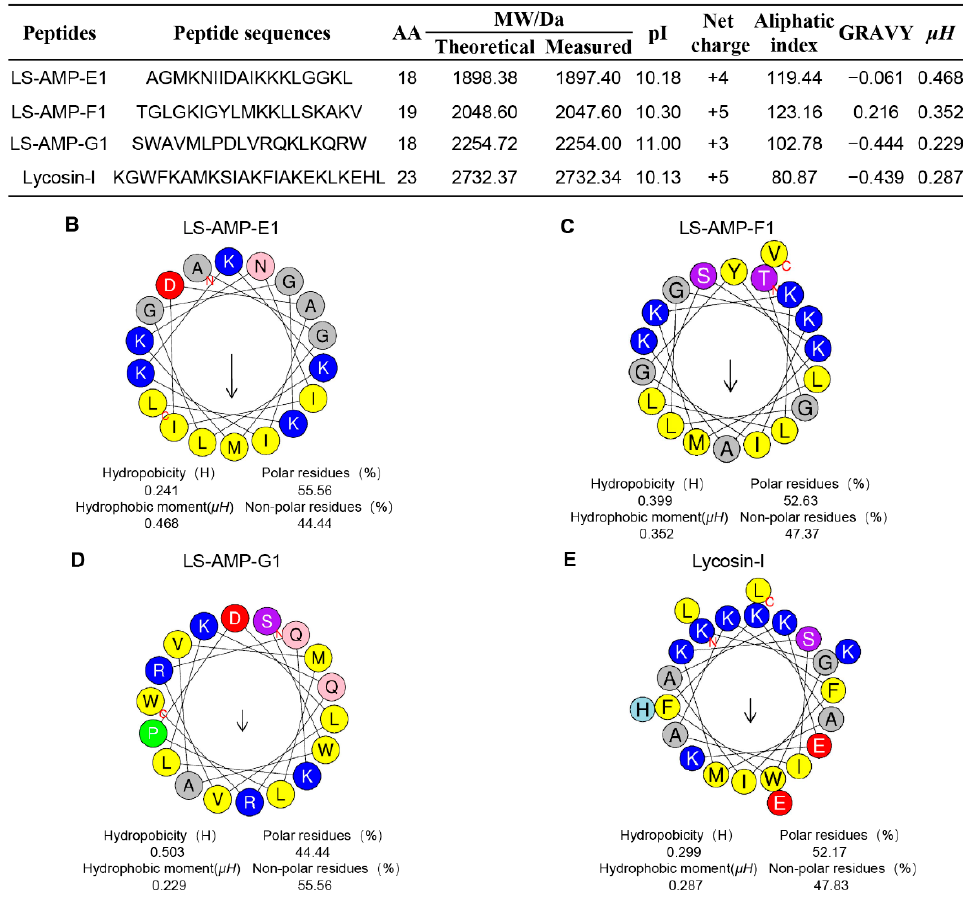
Figure 1. Physicochemical properties ( A ) and helical wheel projection of LS-AMPs ( B ), LS-AMP-E1; ( C ), LS-AMP-F1; ( D ), LS-AMP-G1; ( E ), Lycosin-I. The hydrophobic residues are yellow, positively charged hydrophilic residues are blue, and negatively changed hydrophilic residues are red. The noncharged polar residues are purple. Abbreviations, MW/Da: average molecular mass; pI: isoelectric point; µH : hydrophobic moments; GRAVY : grand average of hydropathicity.